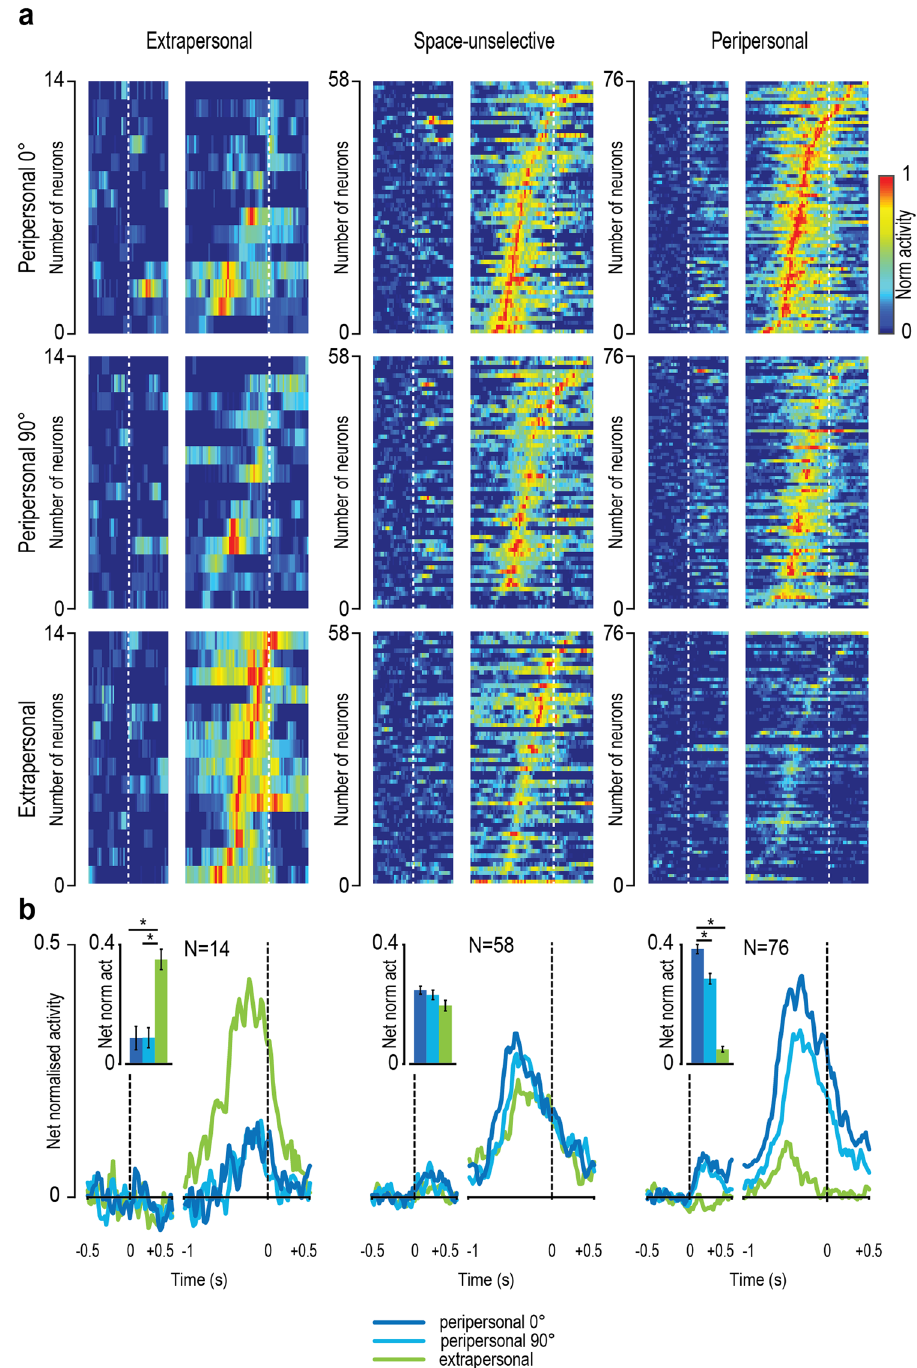
Figure 3. Population dynamic of MNs with different spatial selectivity during action observation in the three experimental conditions. ( a ) Normalised raw activity (no baseline subtraction) of each set of MNs. Each row represents a single neuron. In each panel neurons have been ordered based on the timing of their peak of activity (earliest on bottom) within that condition. White dashed lines represent the different alignment events: first (on the left, before the gap) object presentation, second (on the right, after the gap) object-pulling onset. ( b ) Net normalised population activity of each set of MNs. Black dashed lines correspond to the same alignment events described in ( a ). Histograms show the average ( ± 1 standard error) of each population activity for each condition. * P <